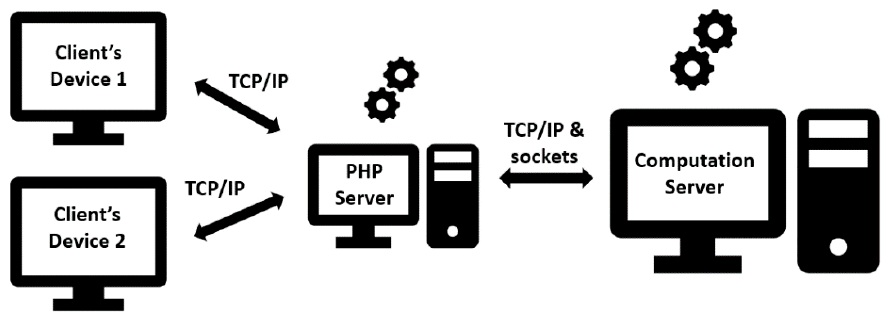
Figure 3. Communication between client’s device, PHP server and computation server.